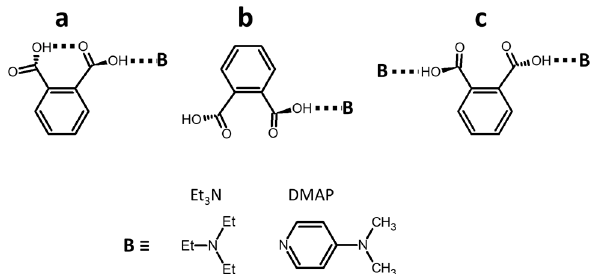
Figure 7. Possible scenarios of phthalic acid interaction with bases in nonpolar solution: ( a ) One intra- and one intermolecular H-bond, ( b ) single intermolecular H-bond, and ( c ) two intermolecular H-bonds. Molecular structures of the considered bases.